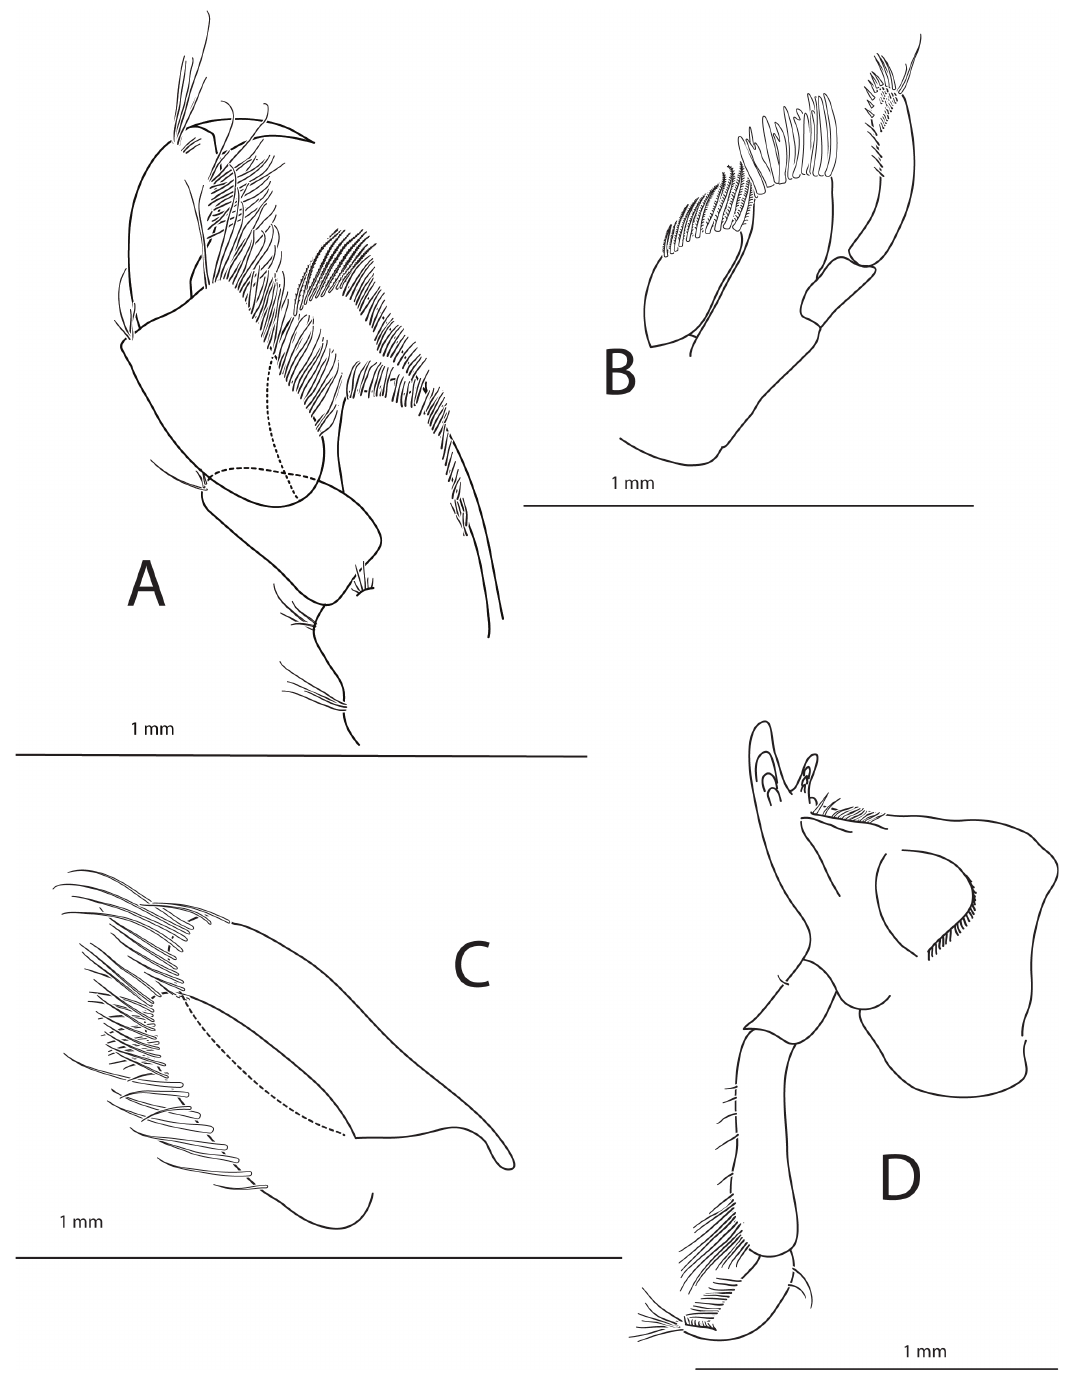
Fig. 4. Halirages helgae sp. nov., holotype, ♀ , 10 mm long. A . Maxilliped. B . Maxilla 1. C . Maxilla 2. D .